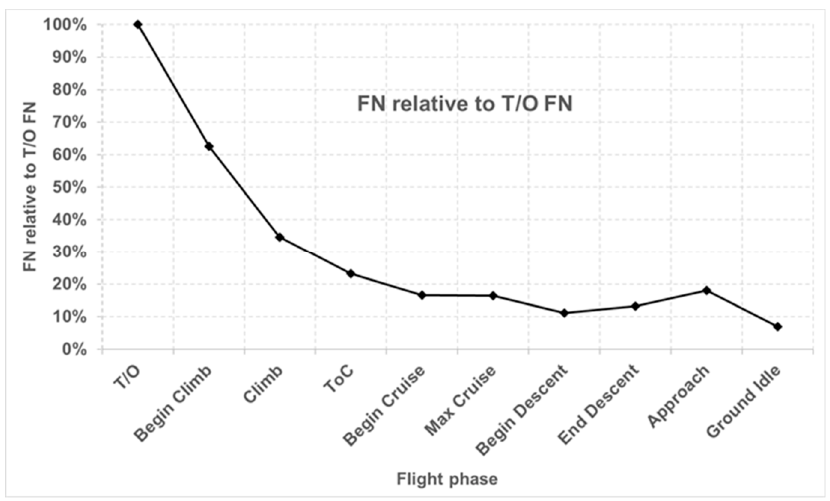
Figure 4. FN profile relative to T/O value.